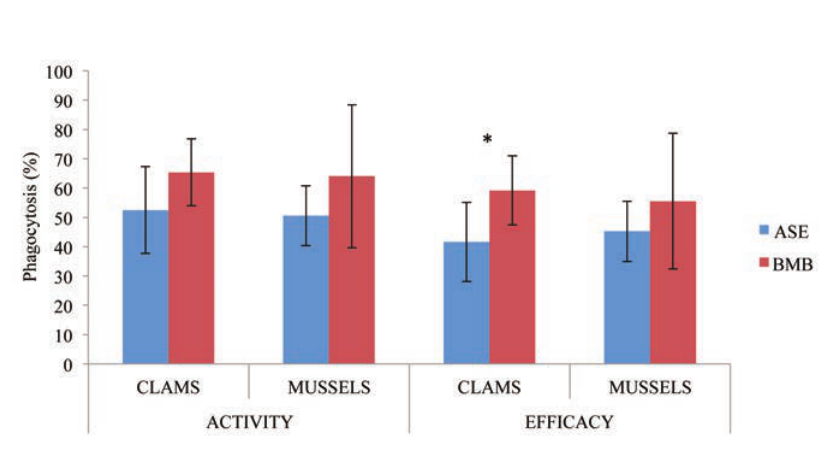
Figure 2. Phagocytic activity (1 bead and more) and efficacy (3 beads and more) of Mya arenaria (n=15) and Mytilus edulis (n=15) from two reference stations in the Saguenay River in a salinity gradient (ASE; 18 psu and BMB; 28 psu). *Significant difference between station,